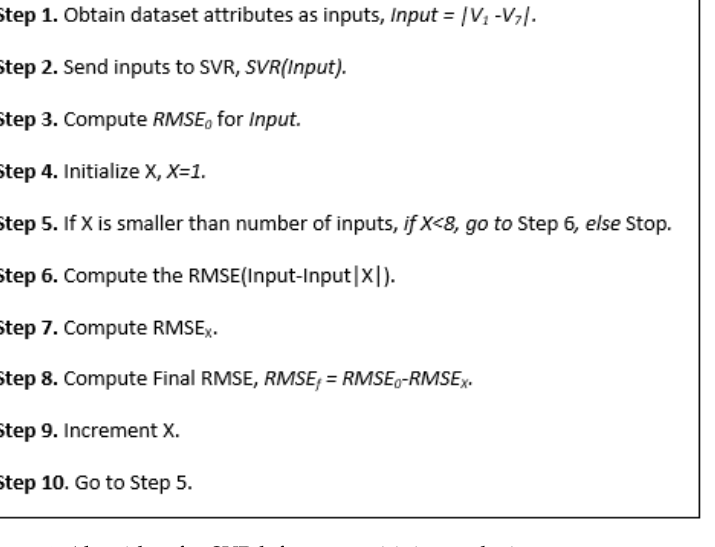
Figure 4. Algorithm for SVR left ‐ out sensitivity analysis.